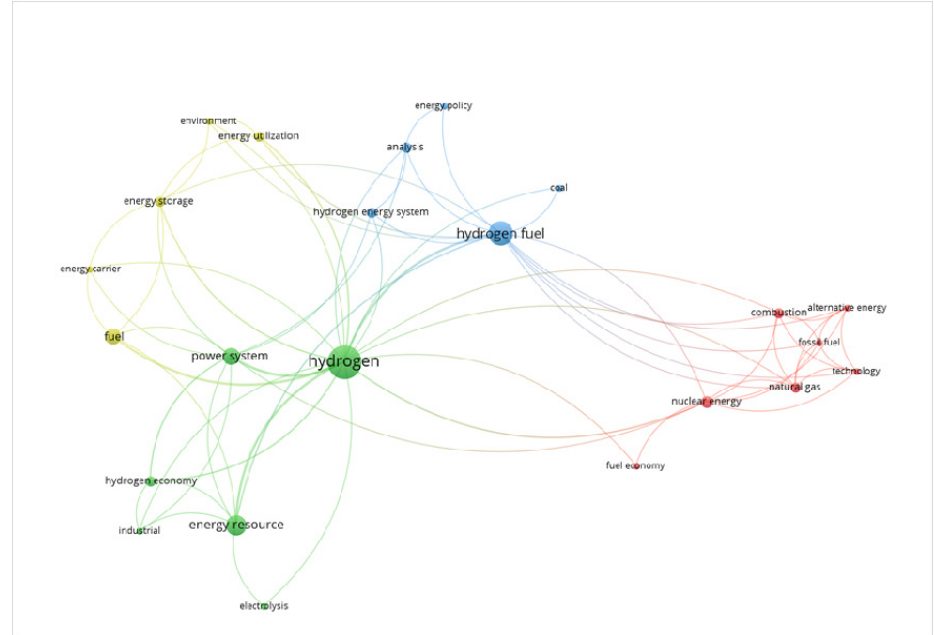
Figure 2. Keyword network map for 1972 to 1979.